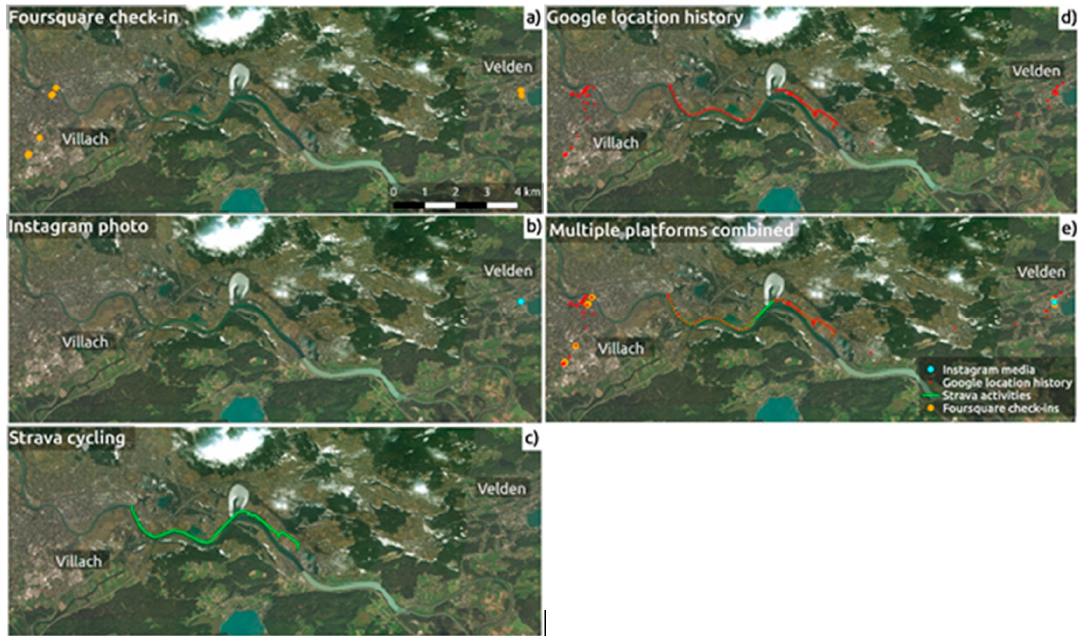
Figure 3. Spatial representation of user activities extracted from single platforms for a day ( a )–( d ), and data sources combined together providing a more complete picture of the user’s activity locations ( e ).